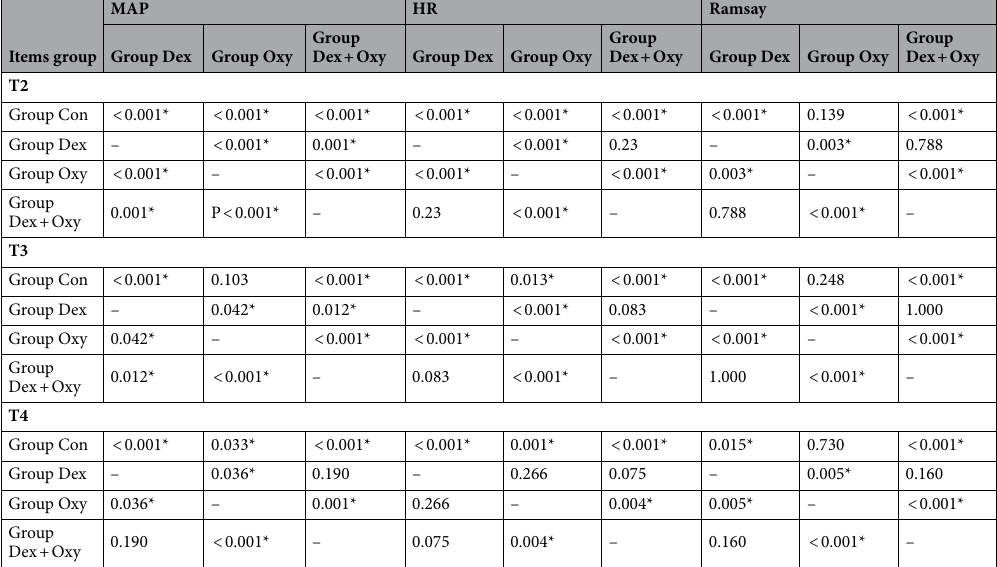
Table 2. The P values of LSD and Games-Howell test for MAP, HR, and Ramsay at the time points of T2-T4. MAP mean arterial pressure, HR heart rate, T2 working cannula establishment, T3 nucleus pulposus removal, T4 immediately postoperation. *Difference was statistically significant; “–” The same group;